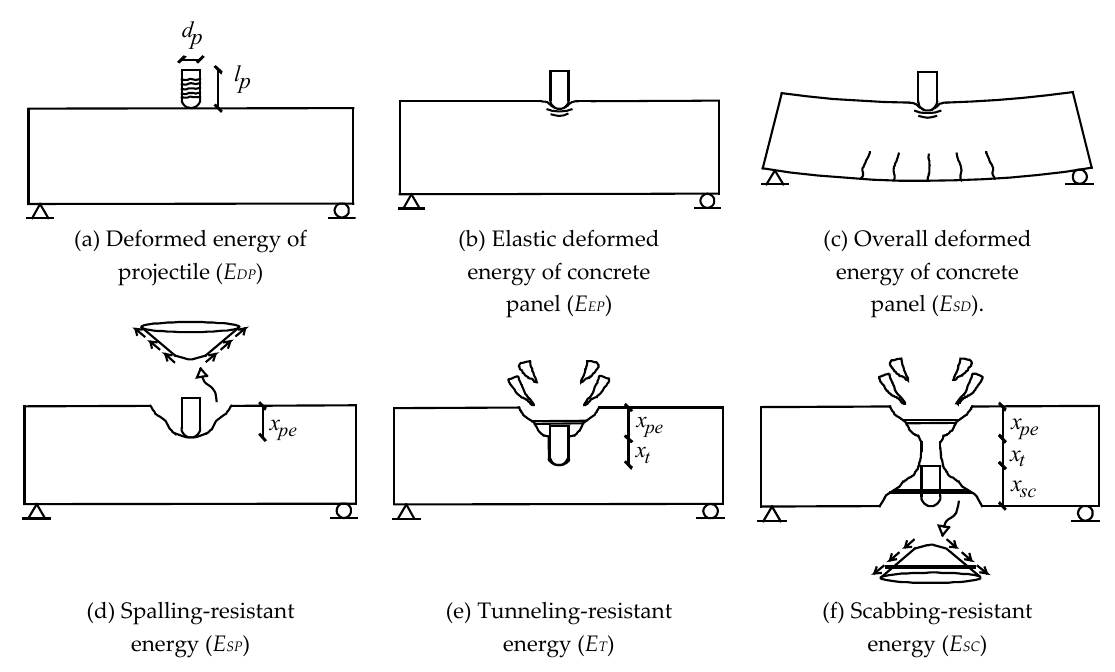
Figure 2. Energies involved in impact mechanism.